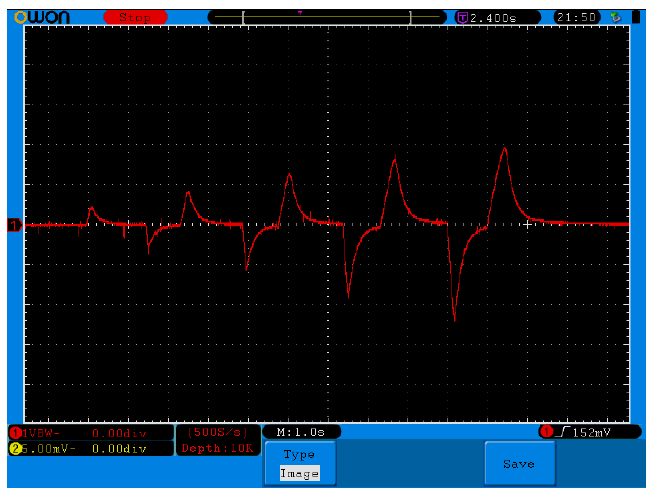
Figure 5. Cycling 1 mm per second with increasing travel. Vertical 5 V per cm, Horizontal 1 s per cm.